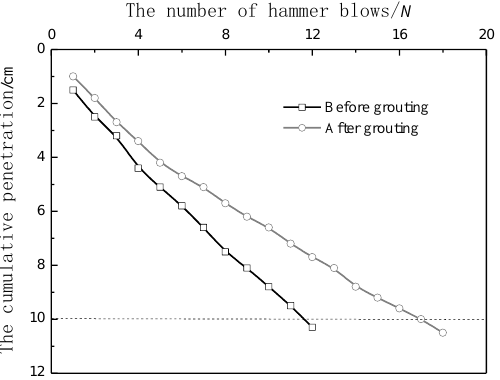
Figure 10. Comparison of dynamic penetration test of No. 1 pile before and after grouting.